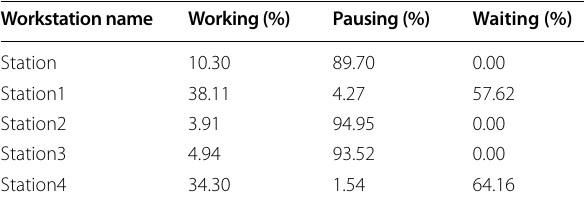
Table 3 Work rate of each work